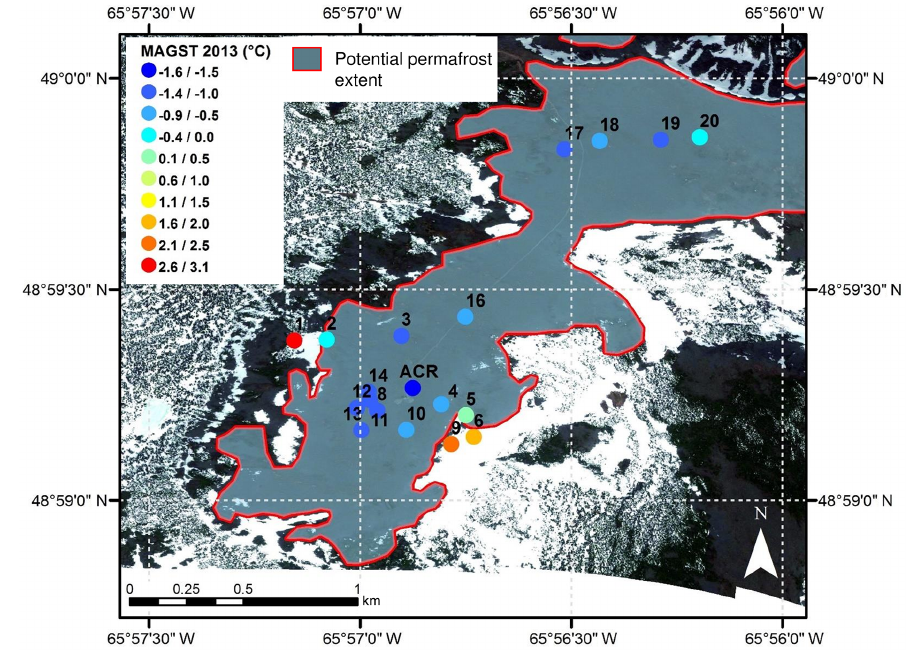
Figure 12. Map of potential permafrost distribution based on the snow and vegetation distribution extracted from the satellite image Spot-5 taken on 28 May 2013. The mean annual ground surface temperatures (MAGST) of 2013 have been added for validation. Each sensor appears as a point and is